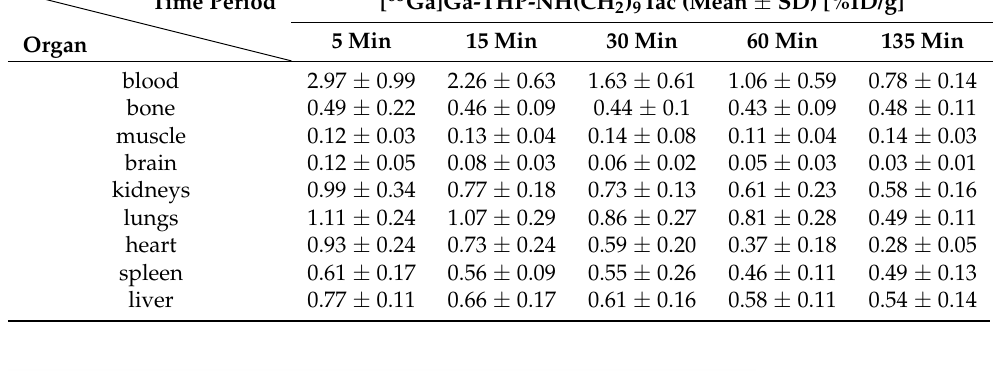
Int. J. Mol. Sci. 2022 , 23 , 8405 Table 3. [ 68 Ga]Ga ‐ THP ‐ NH(CH 2 ) 9 Tac uptake in selected rat organs determined after different time p.i. by ex vivo radioactivity measurements.